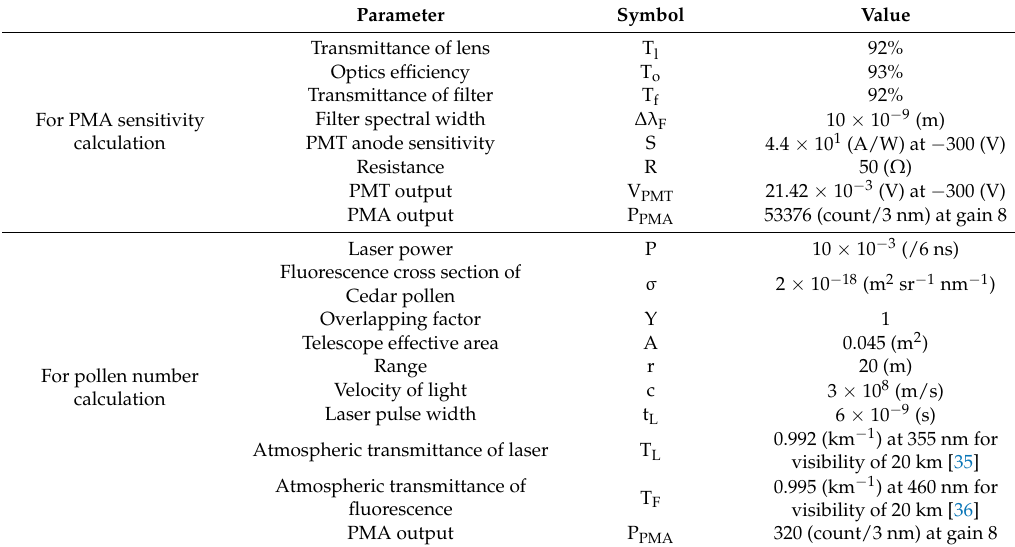
Table 1. Calculation